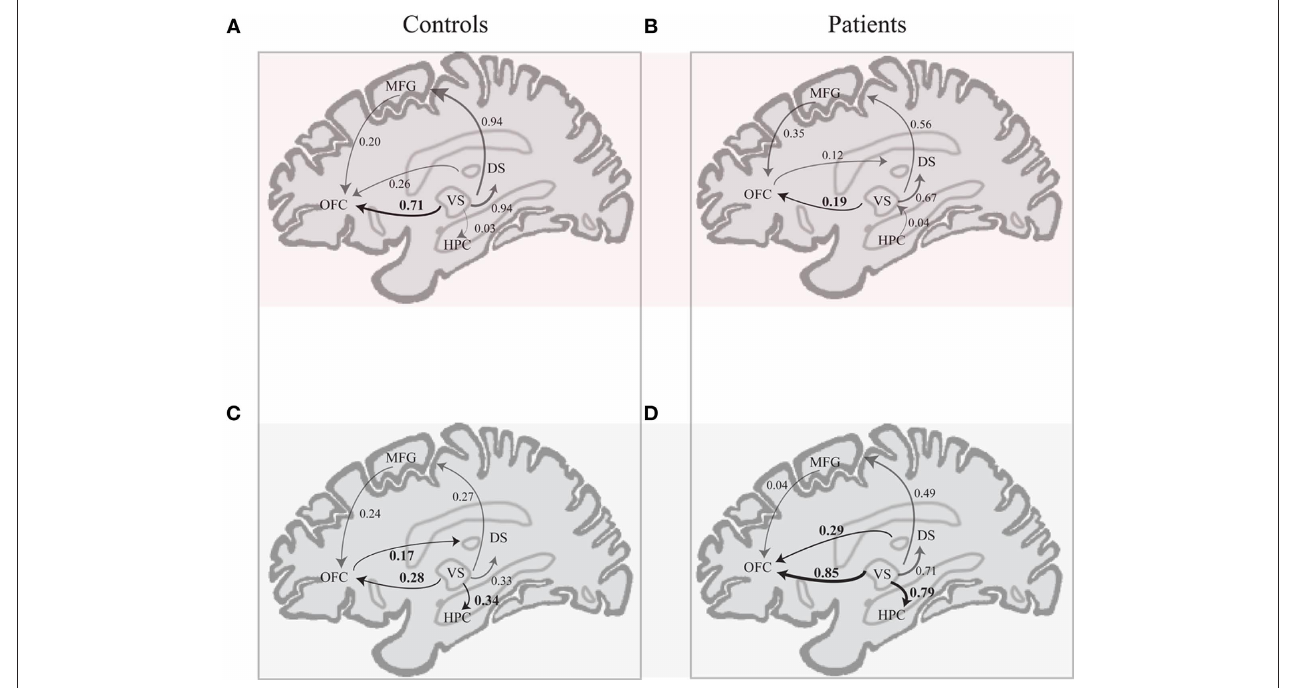
FIGuRe 5 | Schematic of effective connectivity network associated with the control and the schizophrenia patient group in the CS+ condition (A,B) and in the CS − condition (C,D). The regions illustrated in this diagram include: the ventral striatum (VS), putamen and caudate (dorsal striatum or DS), hippocampus (HPC), superior medial frontal gyrus (MFG; BA 10), and orbitofrontal cortex (OFC; BA